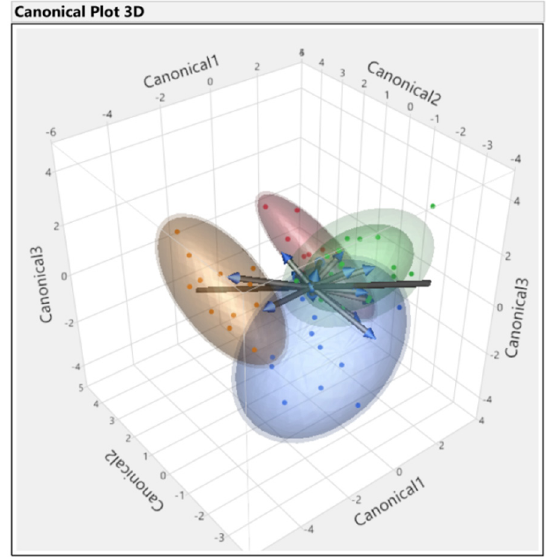
Figure 3. The 3D canonical plot of QDA results in discrimination of four groups based on the discrimination of all parameters, including the Shoot L, Shoot N, Leaf A, RWC, Chl a , Chl b , Chl a/b , Chl total, EL, MDA, proline, sugar, protein, CAT, APX, POX, and Sod. Groups were determined with different colors (green for tolerant, pale green for semi-tolerant, pale red for semi-susceptible, and red for susceptible).